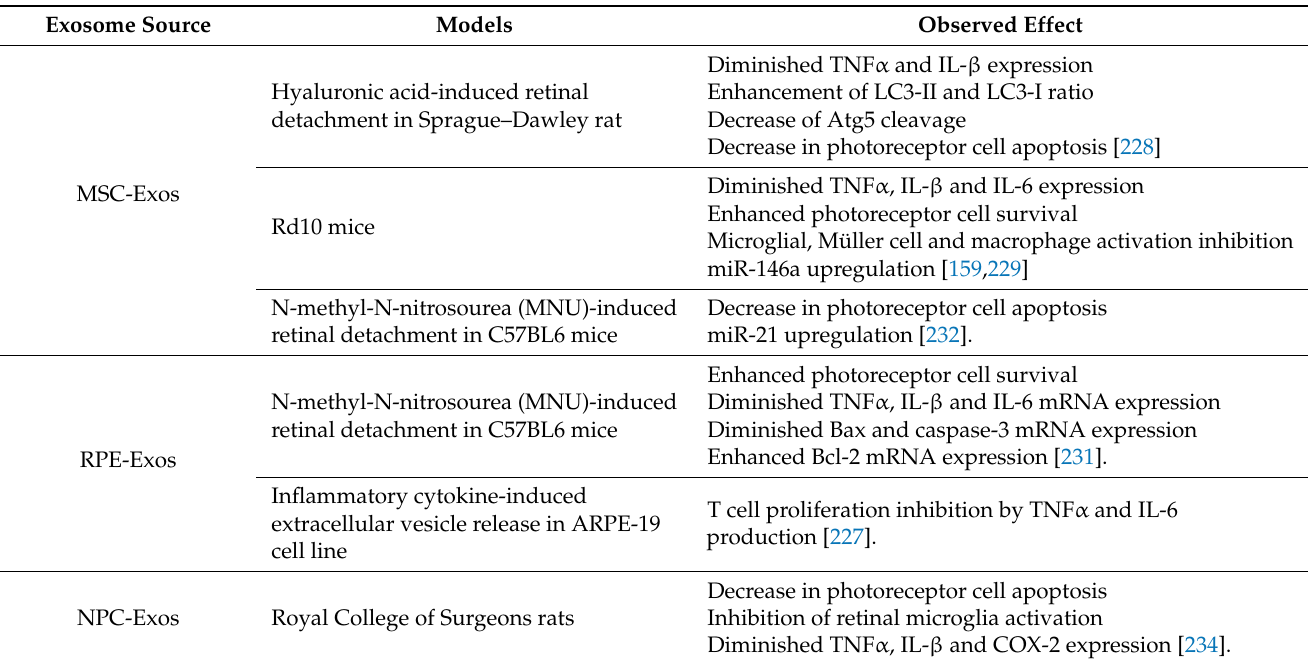
Table 2. Summary of preclinical studies involving exosome use for the treatment of retinitis pigmen- tosa. This table provides a summary of current preclinical studies investigating the use of exosomes in the potential treatment of retinitis pigmentosa. We cover functions of mesenchymal stem cell-derived exosomes (MSC-Exos), retinal pigmented epithelium-derived exosomes (RPE-Exos), and neural progenitor cell-derived exosomes (NPC-Exos) on different animal